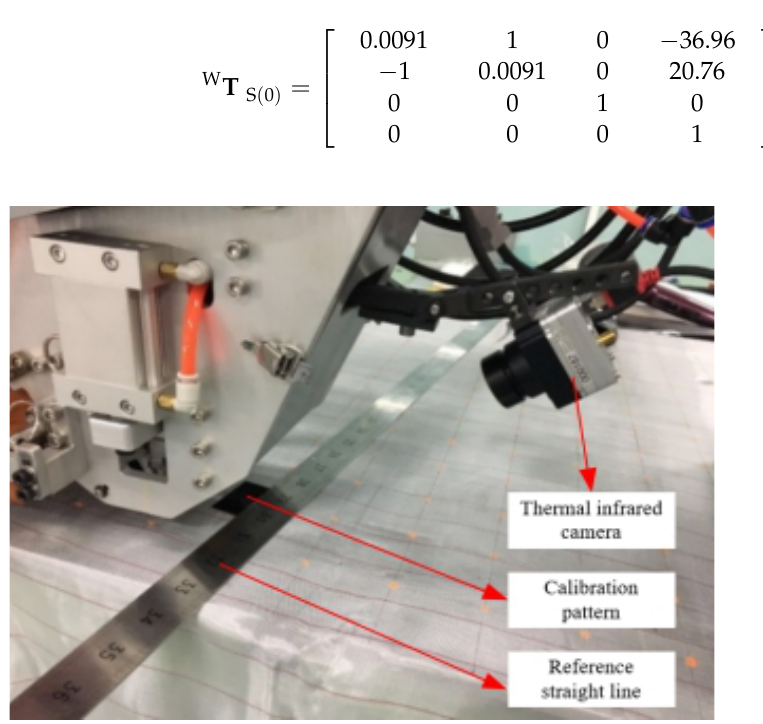
Figure 7. Parameters calibration. Positions were measured by the proposed method several times. The measurement results were compared with those measured by the robot’s calibration needle. For all of the points to be measured, we denoted them as A1~A3. The robot’s calibration needle was set on the measured points, as shown in Figure 8. The robot system would obtain their coordinates in { W }. Then, these points were measured with the proposed infrared visual system. The measured results are all shown in Table 2.